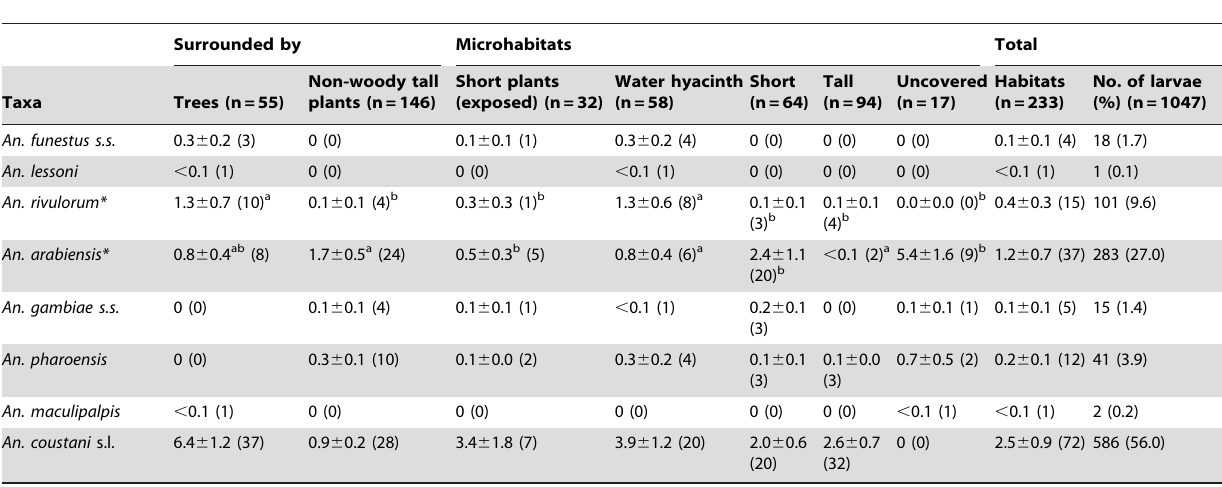
Table 2. Mean densities 6 SE (per site) and occurrences of anopheline larvae sampled from the water hyacinth and non-water hyacinth habitats that were surrounded by trees or other tall emergent plants or were exposed to waves in the lake, and from microhabitats categorized based on vegetation cover at each sampling site in 2009.